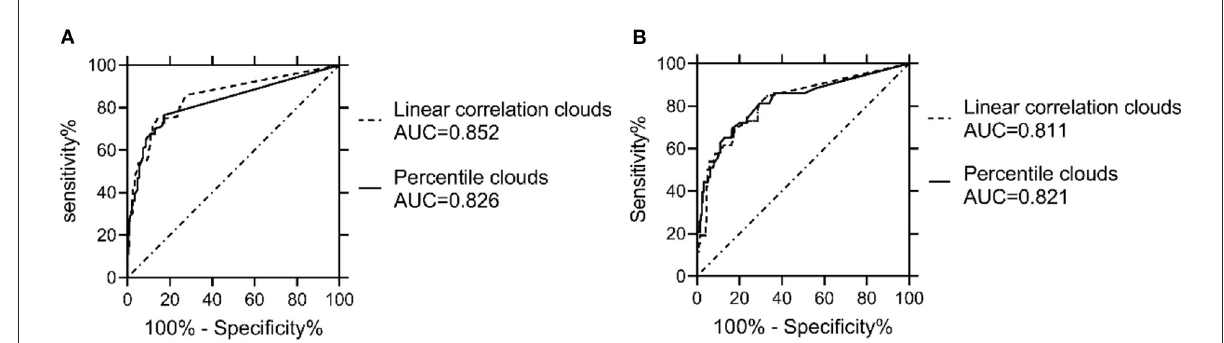
FIGURE5 Comparison of ROCs and AUC between the linear regression clouds and percentile clouds. The ROCs were drawn with the percentage of data points beyond the boundaries of the linear regression clouds and percentile clouds, The AUC of the linear regression clouds and percentile clouds were both > 0.8. AUC = area under the curve. (A) The AUC of both the linear regression clouds and percentile clouds that were used to discriminate neuropathic vs. non-neuropathic lesion were > 0.8. (B) The AUC of both the linear regression clouds and percentile clouds that were used to discriminate myopathic vs. non-myopathic lesion were > 0.8.